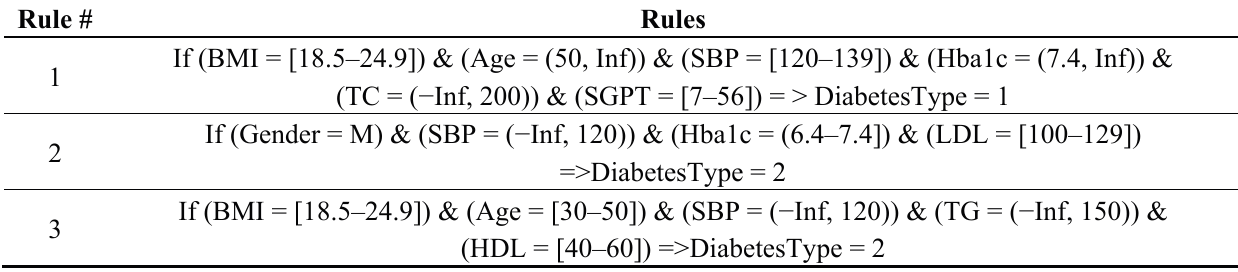
Table 2. A few examples of the rules, created from the unified